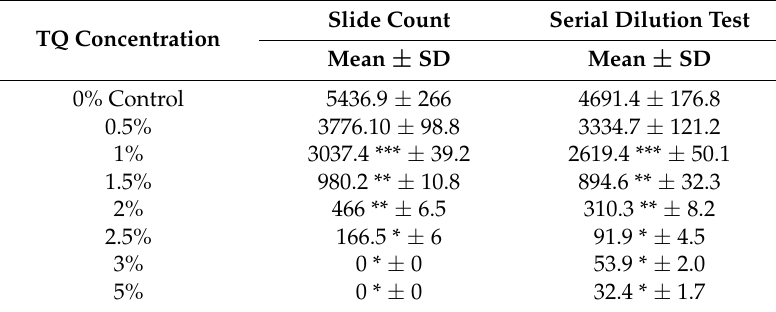
Table 3. Effect of different concentration of TQ on Candida albicans